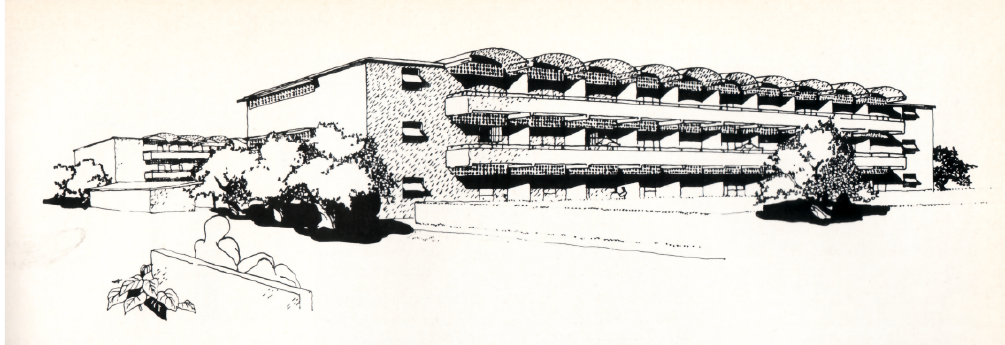
Figure 19. Rendering of African family flats, Satellite Port Tudor. Source: Herrel (2001).